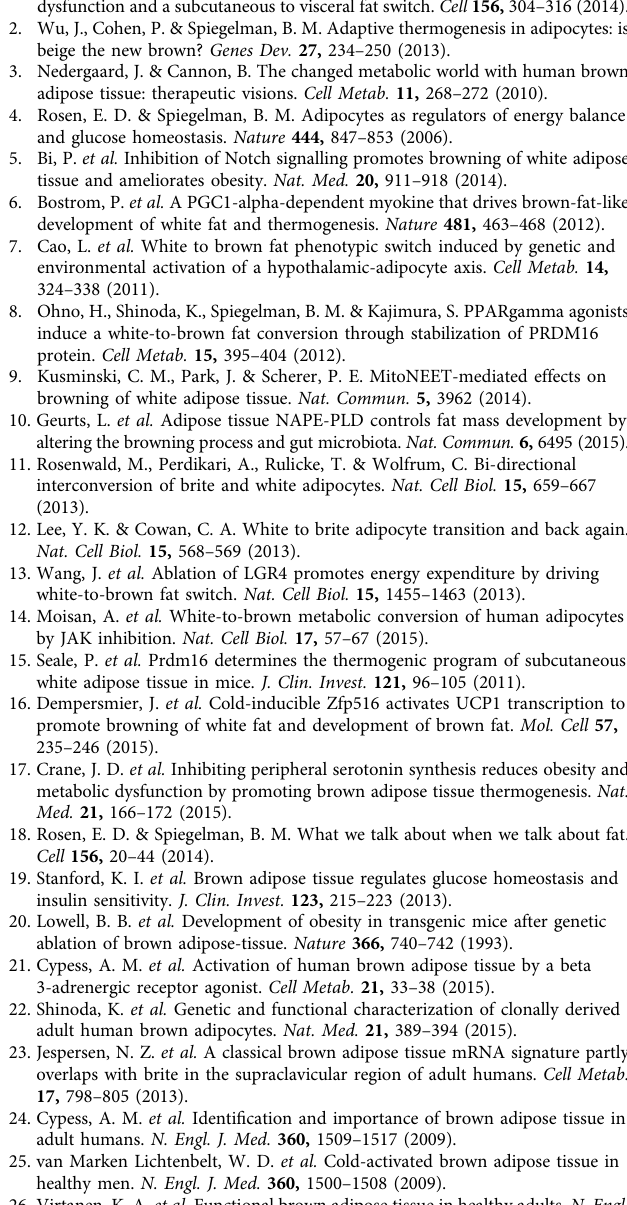
Supplementary Table 1. The 2 (cid:2) DD CT method was used to analyse the relative changes in gene expression normalized against 18S ribosomal RNA as internal control. Protein extraction and western blot analysis . Total protein was isolated from cells or tissues using RIPA buffer contains 50mM Tris-HCl (pH 8.0), 150mM NaCl, 1% NP-40, 0.5% sodium Deoxycholate and 0.1% SDS. The cytoplasm fractions were extract with buffer A contains 10mM HEPES (pH 7.4), 1mM